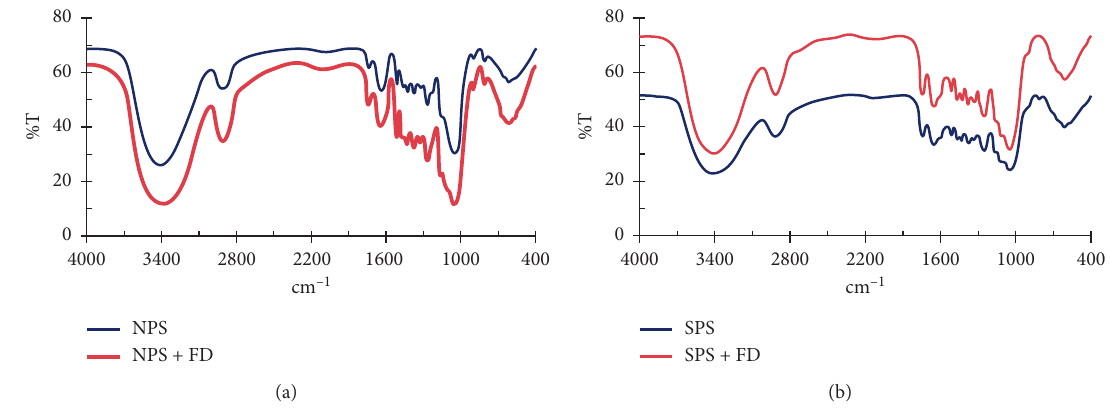
Figure 2: FT-IR analysis of the functional groups in (a) NPS and (b) SPS before and after the adsorption of FD.